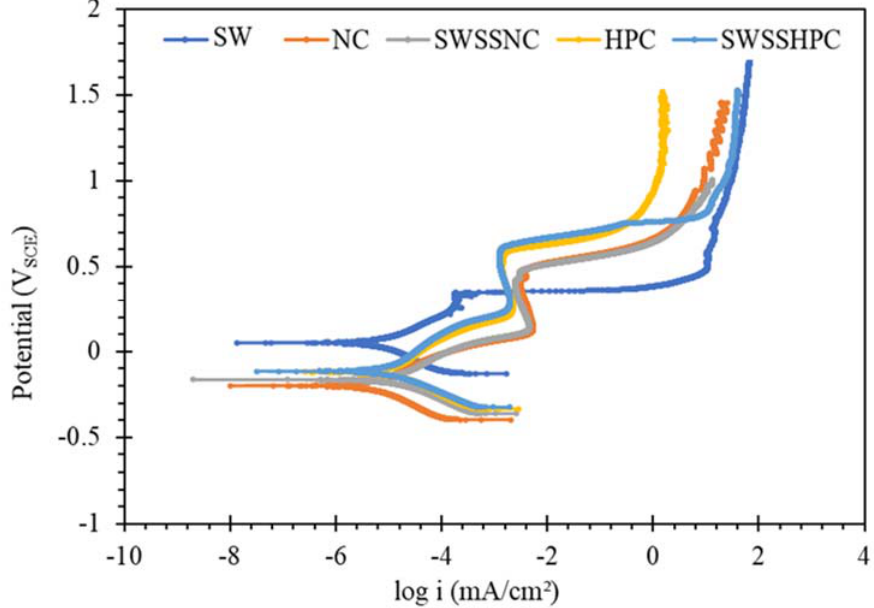
Figure 8. Polarization curves obtained for SS316 exposed to SW, NC, SWSSNC, HPC and SWSSHPC solutions for 168 h.